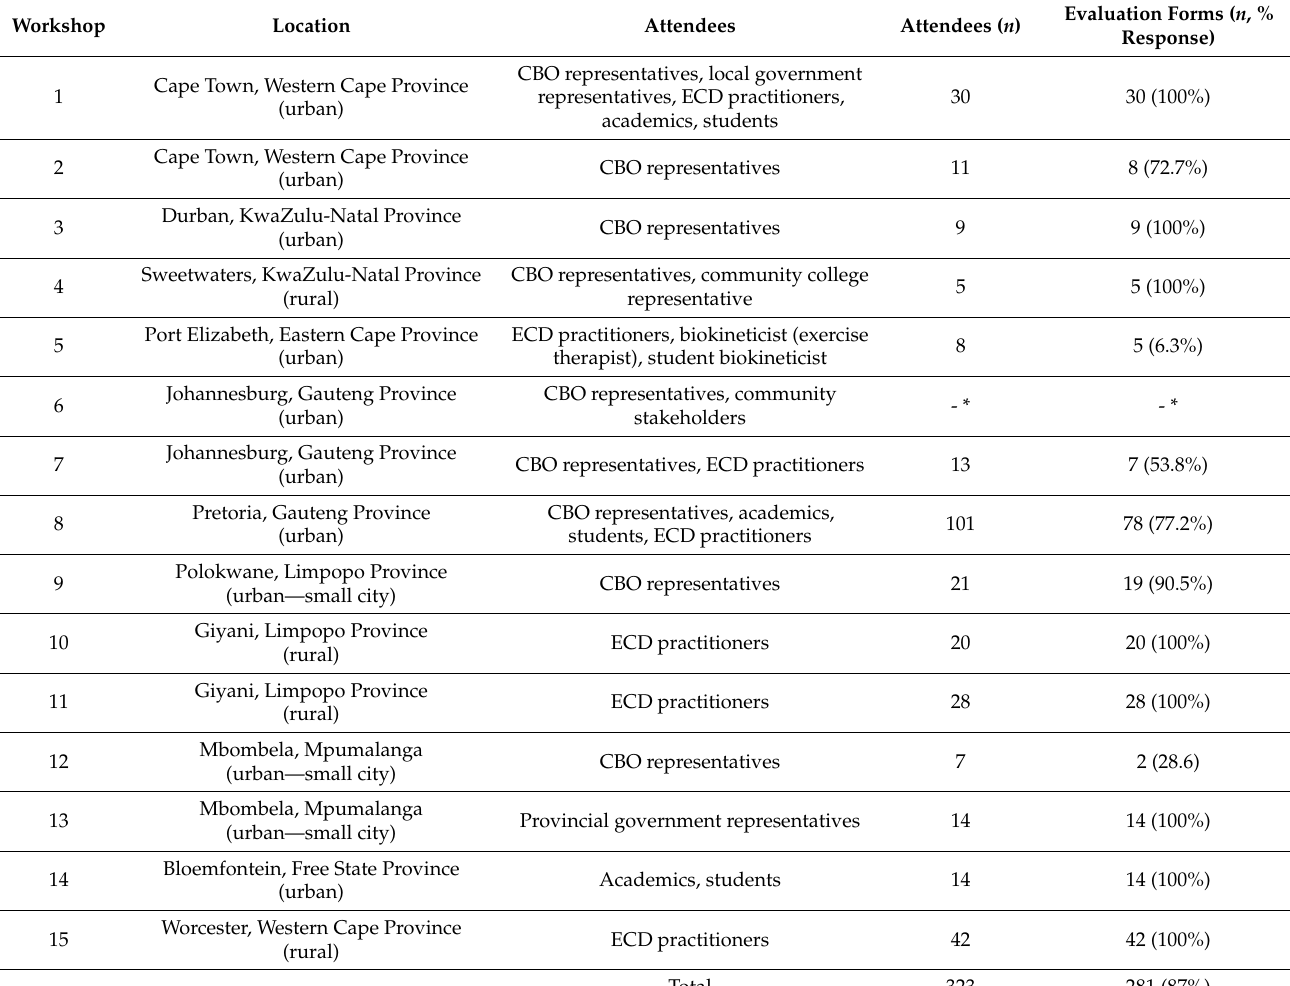
Table 2. Dissemination workshop locations and